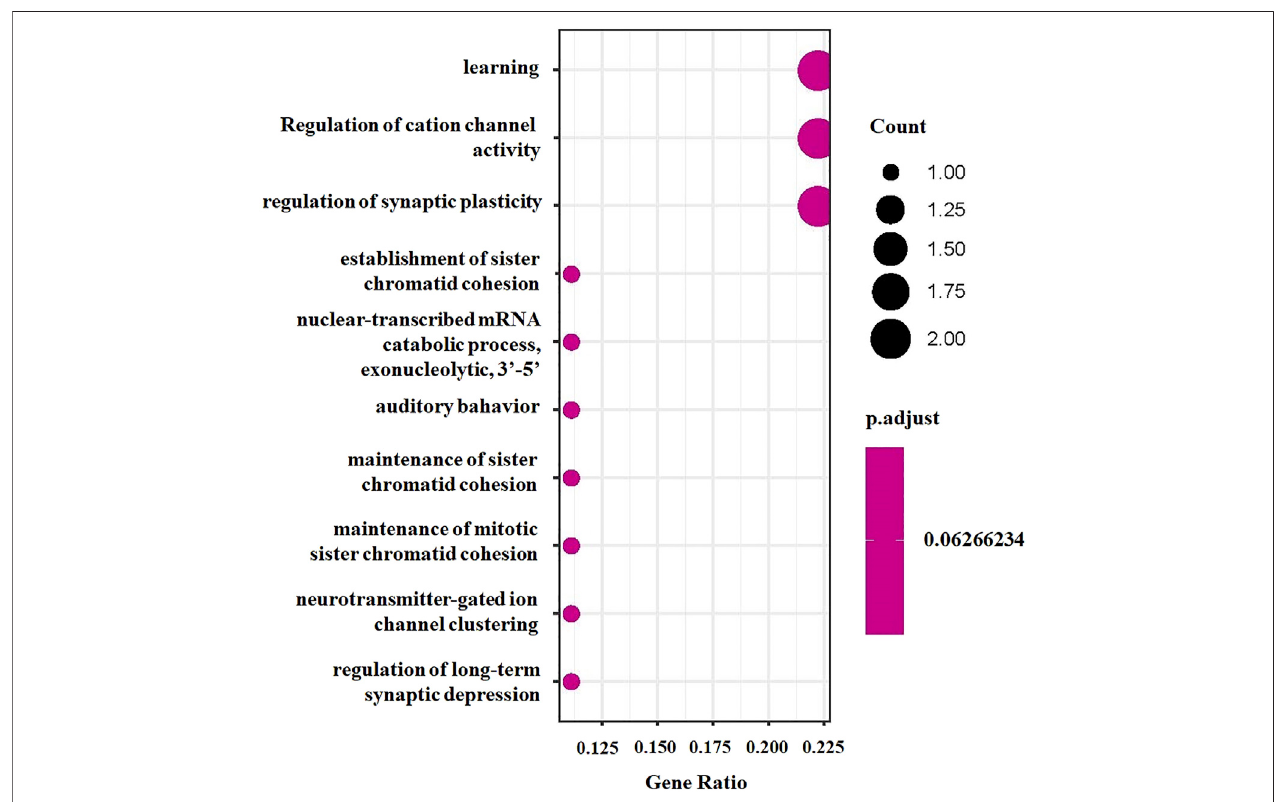
FIGURE 3 | GO enrichment analysis bubble chart for signi fi cant